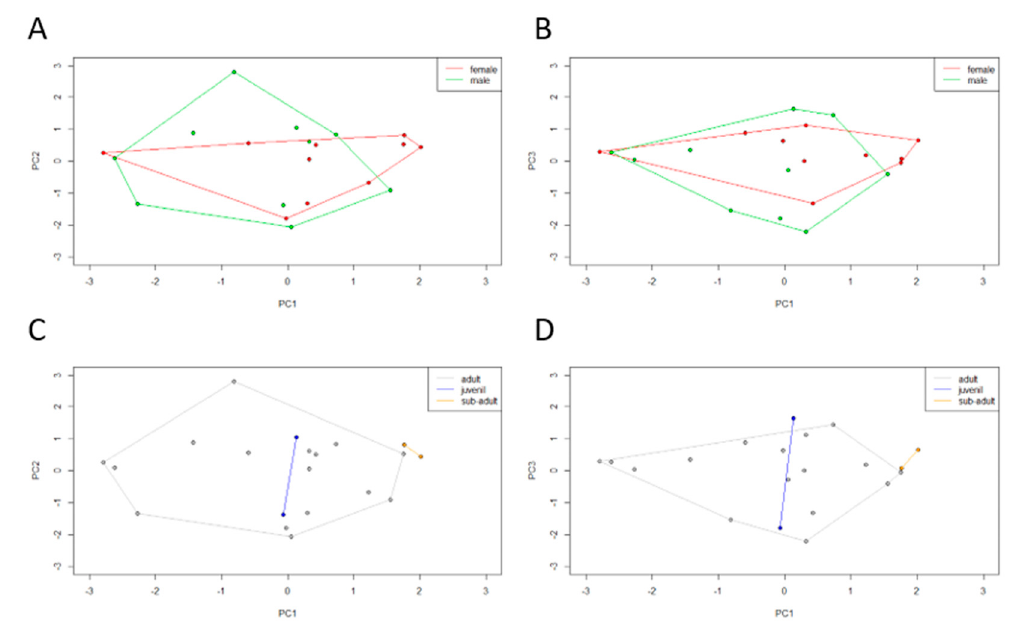
Figure 5. Two principal component (PC) plots depicting the dispersal area of microbiota data of each Egyptian mongoose specimen. The 20 specimens are projected in the ( A , C ) PC1 × PC2 and ( B , D ) PC1 × PC3 planes resulting from a principal component analysis performed on the Boolean matrix of the presence / absence of the di ff erent hierarchical bacterial levels. The vertices of each polygon correspond to the microbiota data observed for each specimen. Each polygon corresponds to ( A , B ) sex and ( C , D ) age class clustering. Microorganisms 2020 , 8 , x FOR PEER REVIEW